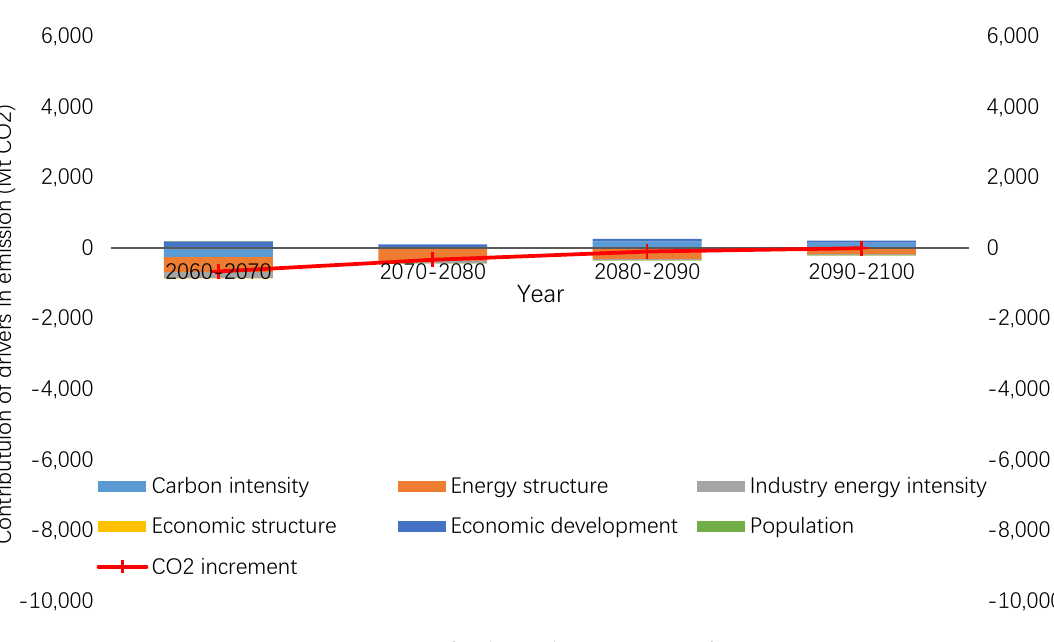
Figure 11. Decomposition of industrial CO 2 emission from 2060 to 2100.